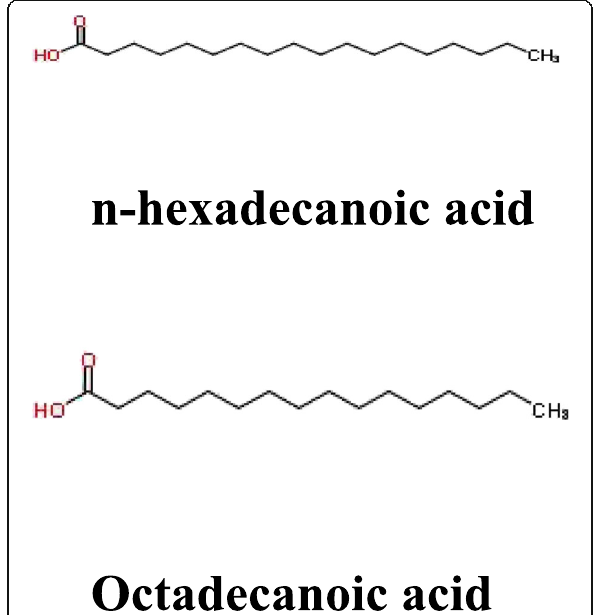
Fig. 5 Structure of n -hexadecanoic acid and octadecanoic